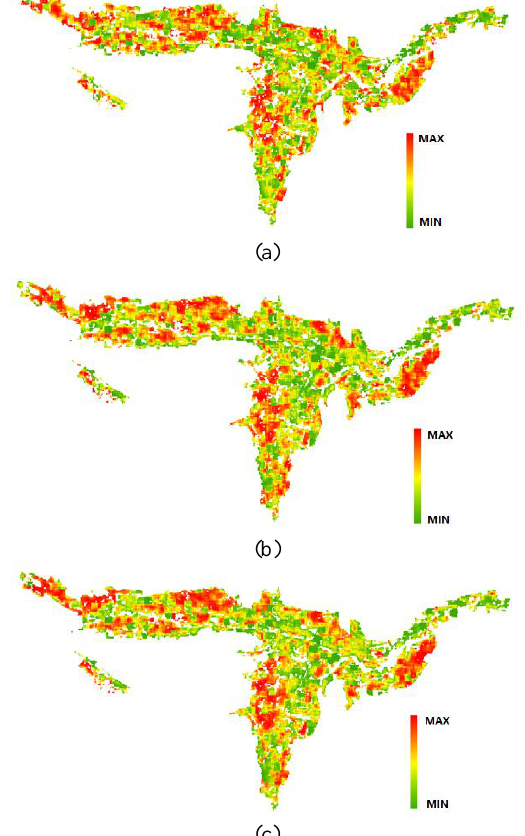
Figure 3. the display of G 0 texture parameter features: (a) VV; (b) HH/HV; (c) Full-polarization SAR.